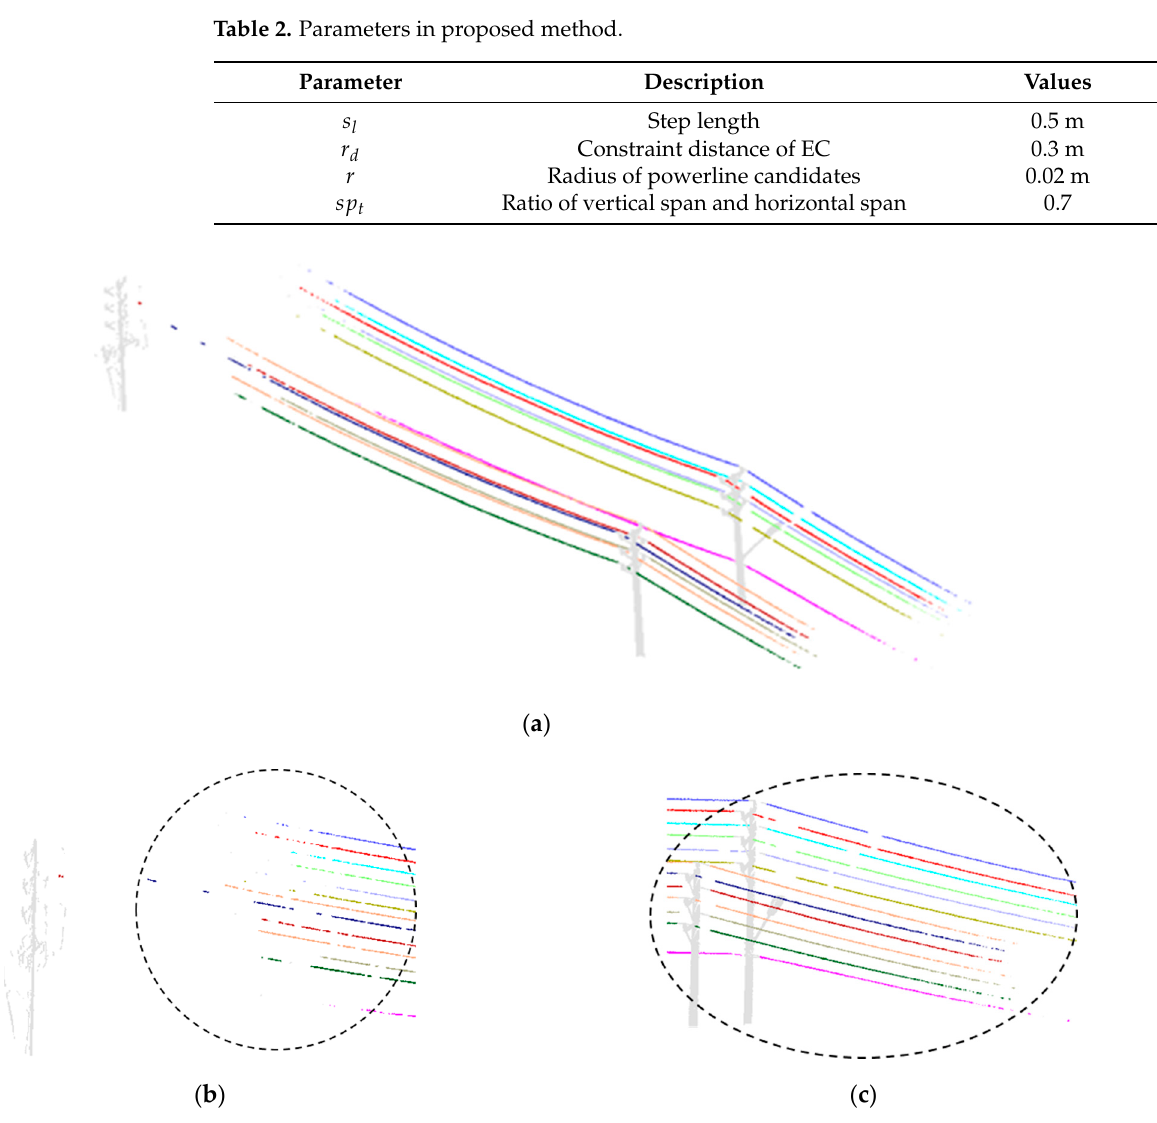
Figure 11. The results of powerline extraction. ( a ) Each single powerline is successfully extracted from preprocessed data directly and shown in different colors. ( b , c ) Clustering with the gaps. Powerlines are clustered correctly.